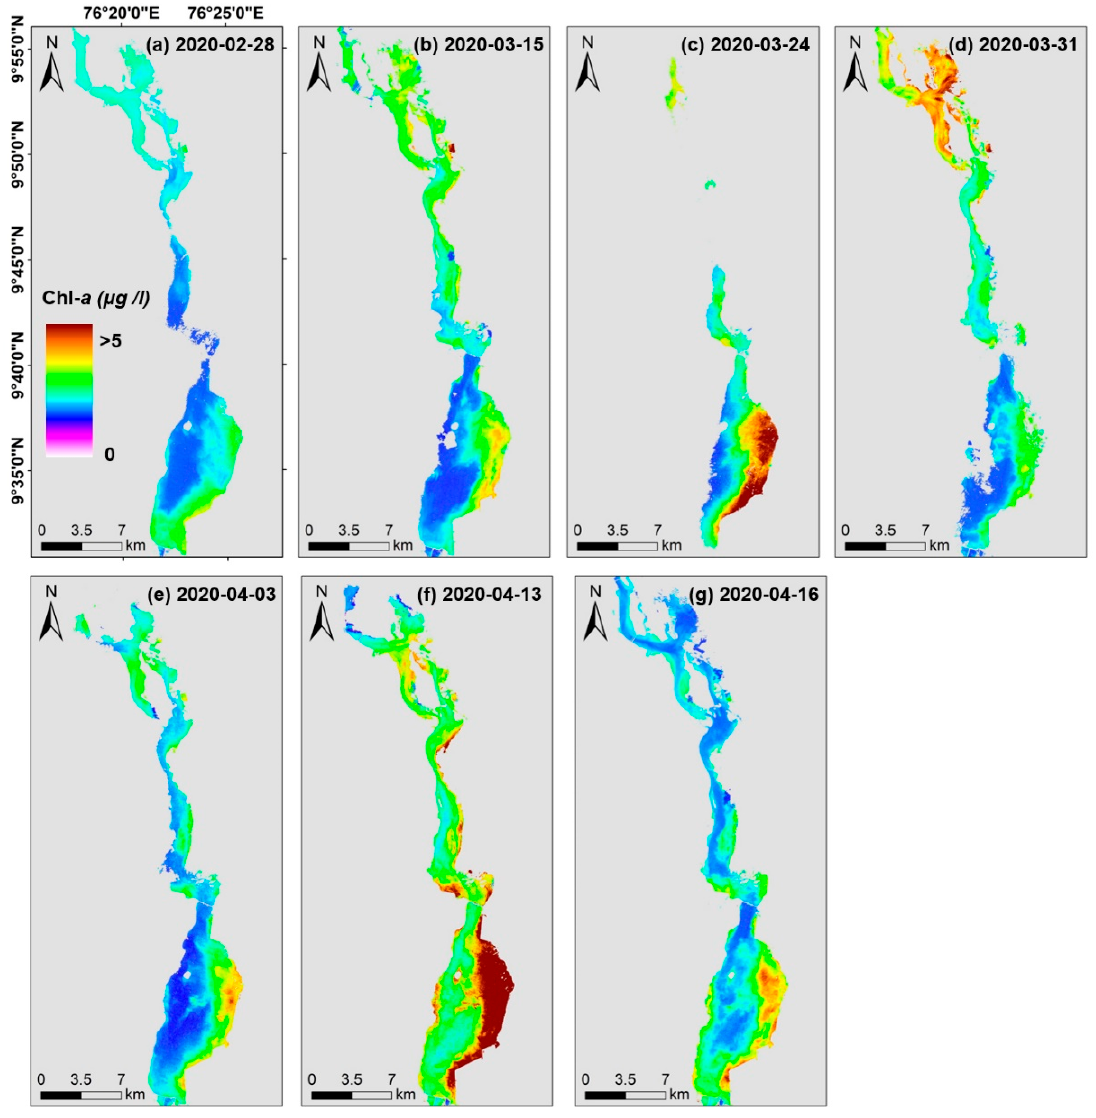
Figure 5. Chlorophyll- a concentrations before and during the lockdown period estimated using OC3 algorithm for Vembanad Lake waters.